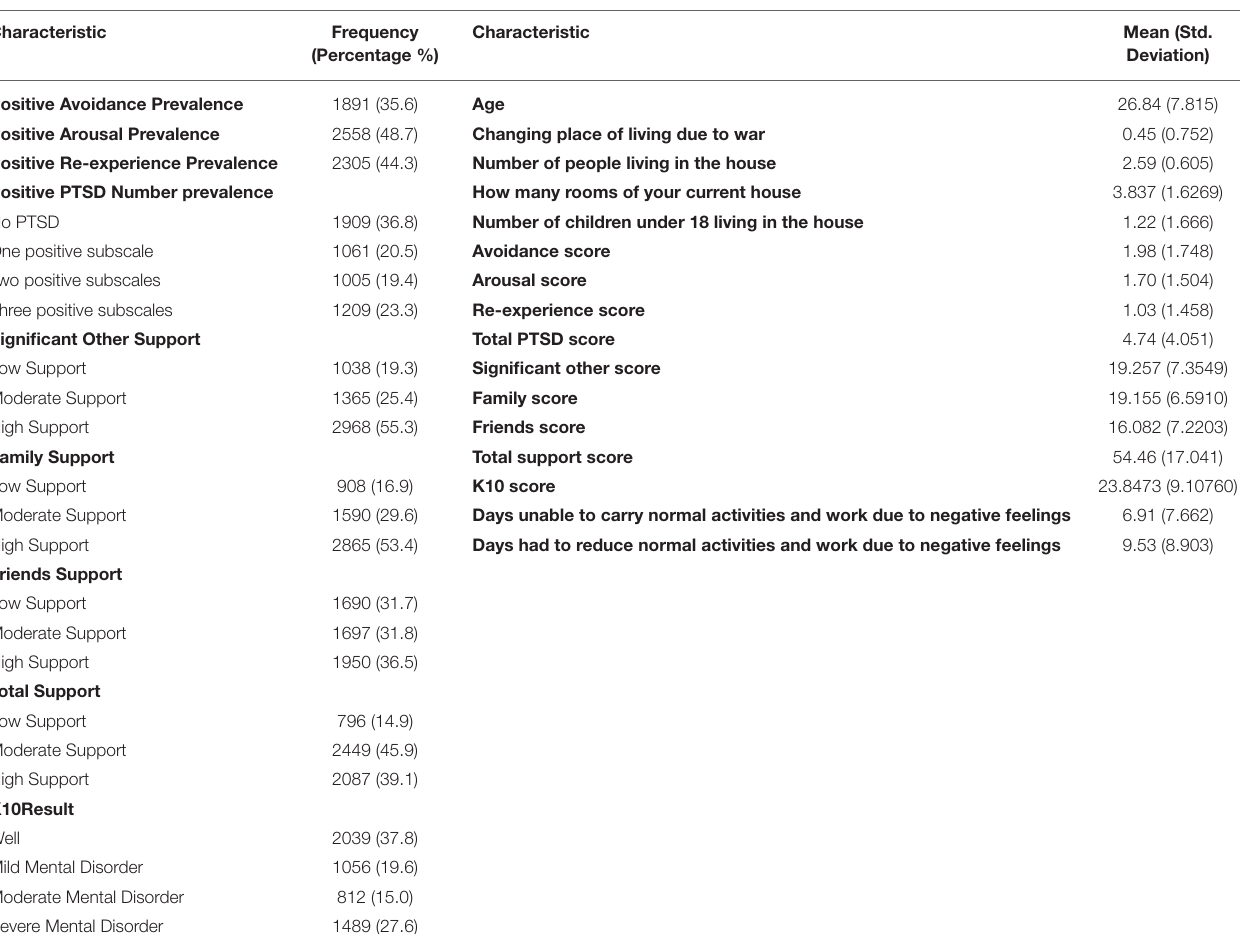
TABLE 2 | Age, PTSD, social support, and K10 results and scores with other numeric variables. Characteristic Frequency Characteristic Mean (Std. (Percentage %)